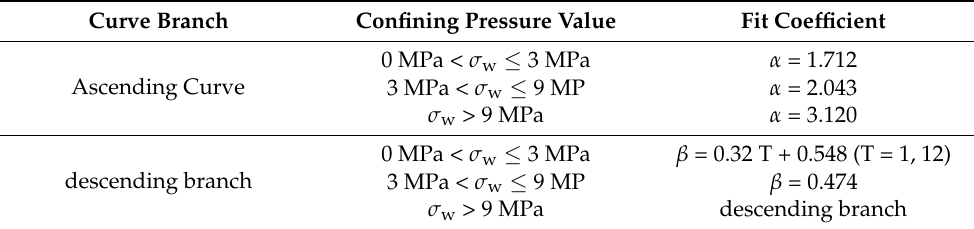
Table 5. Fitting coefficient of constitutive relation under triaxial